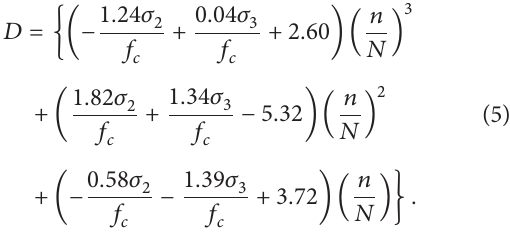
different lateral stress ratios was analyzed using nonlinear regression as shown